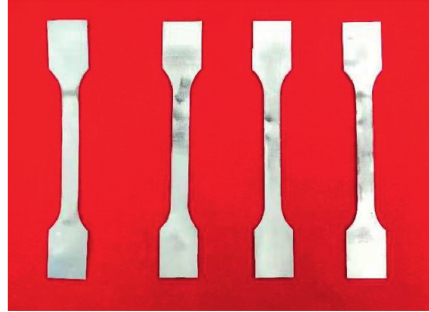
Figure 10: SMA tensile test